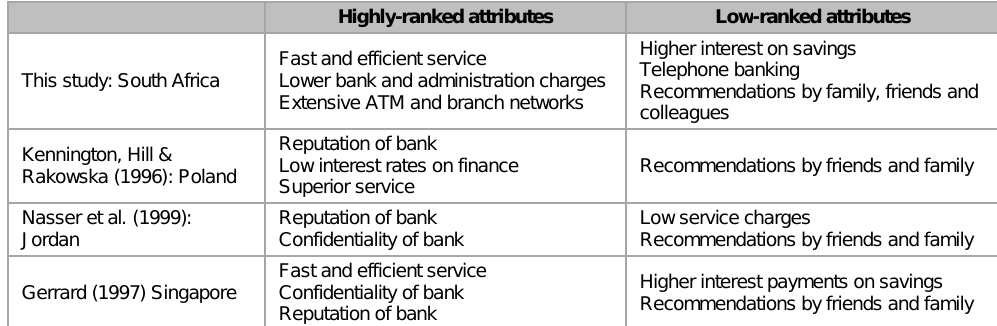
Comparison of key bank selection